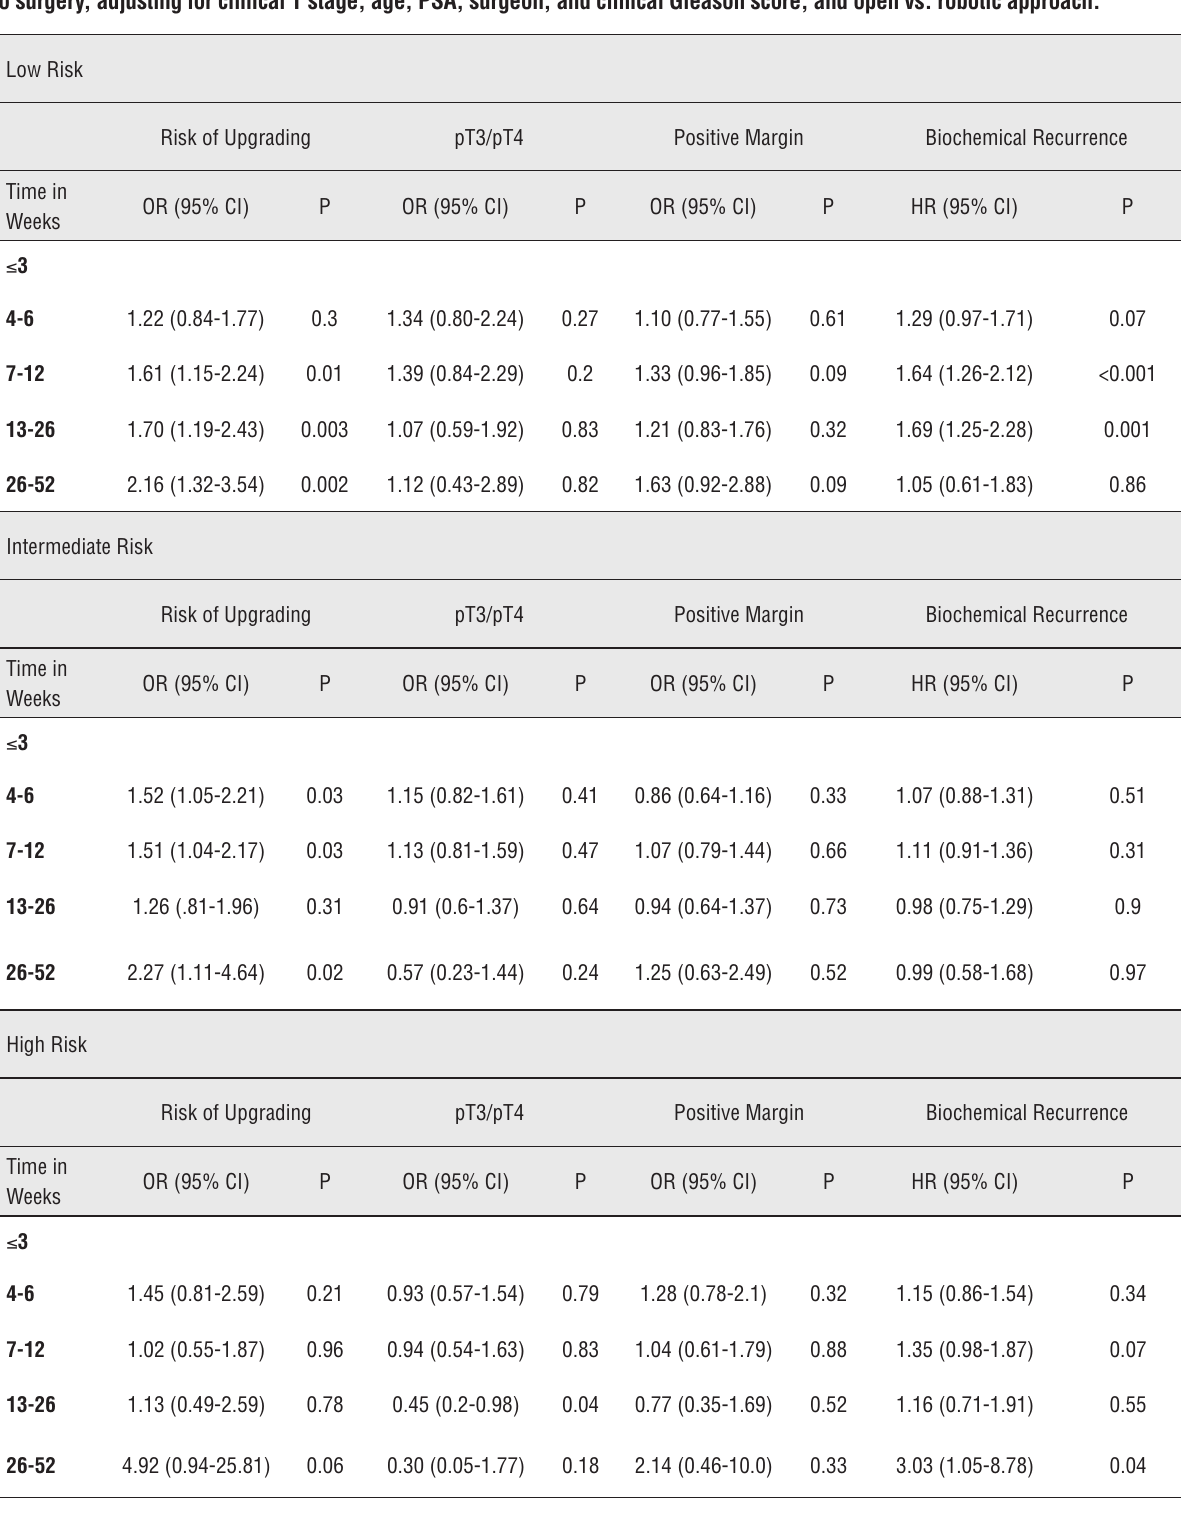
Table 3 - Multivariate regression of oncologic outcomes among low, intermediate, and high risk men stratified by time from biopsy to surgery, adjusting for clinical T stage, age, PSA, surgeon, and clinical Gleason score, and open vs. robotic